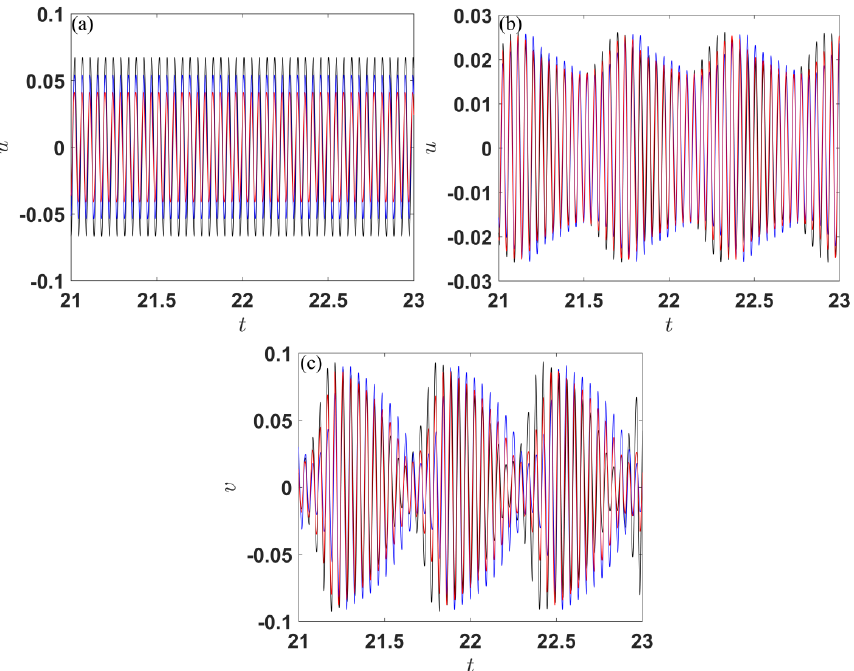
Figure 12. Waveforms of the system for ξ = 0.3, β = 0.15, 0.35, and 0.45; ( a ) beam without NES, ( b ) beam with NES; ( c ) NES; red line: β = 0.15, blue line: β = 0.35, black line: β = 0.45.